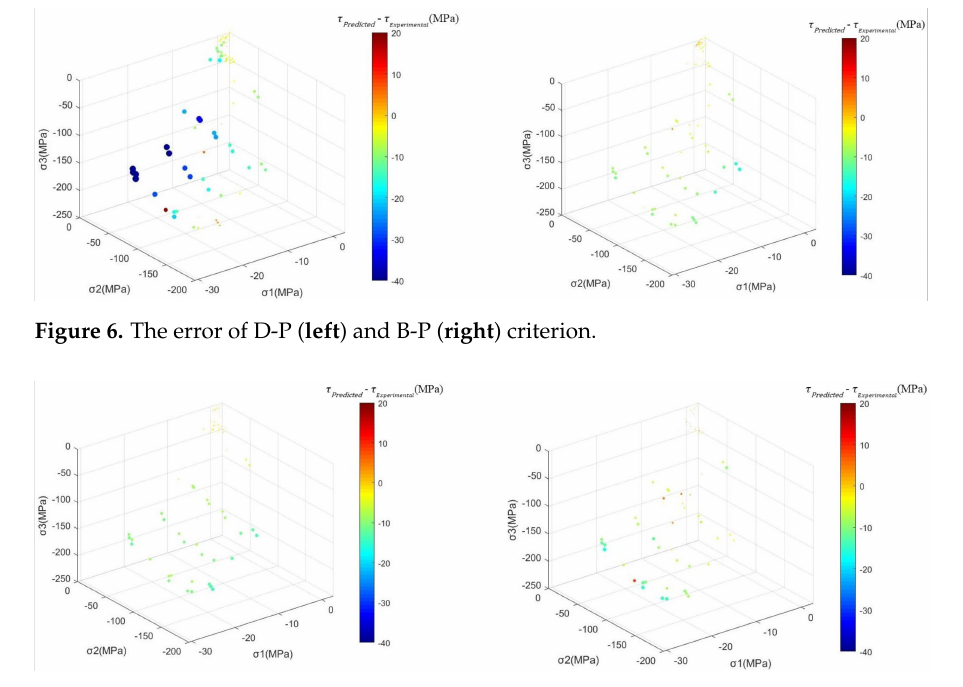
Figure 7. The error of RBF ( left ) and RF ( right )